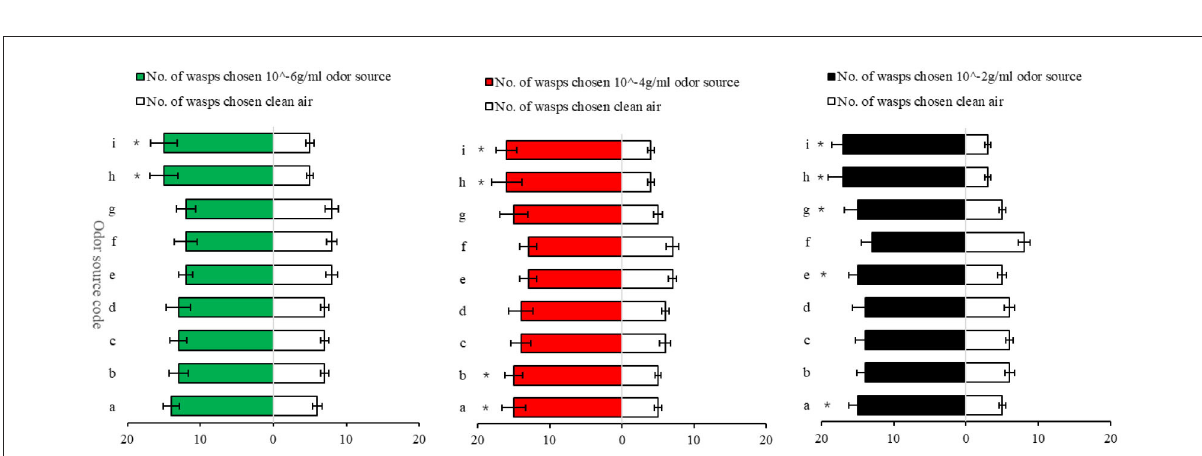
FIGURE2 Attraction of Aphelinus sp. to seven synthetic volatile components identified from tea aphid body rinses and 2 synthetic tea aphid sex pheromone components. a, benzaldehyde; b, 2,5-hexanedione; c, linalool; d, E -2-hexenoic acid; e, heptadecane; f, undecane; g, eicosane; h, (4 aS ,7 S ,7 aR )-nepetalactone; I, (1 R , 4 aS ,7 S ,7 aR )-nepetalactol. *mean the difference between the number of wasps to choose odor source and the number of wasps to choose CK (clean air) reaches a significant level of p <